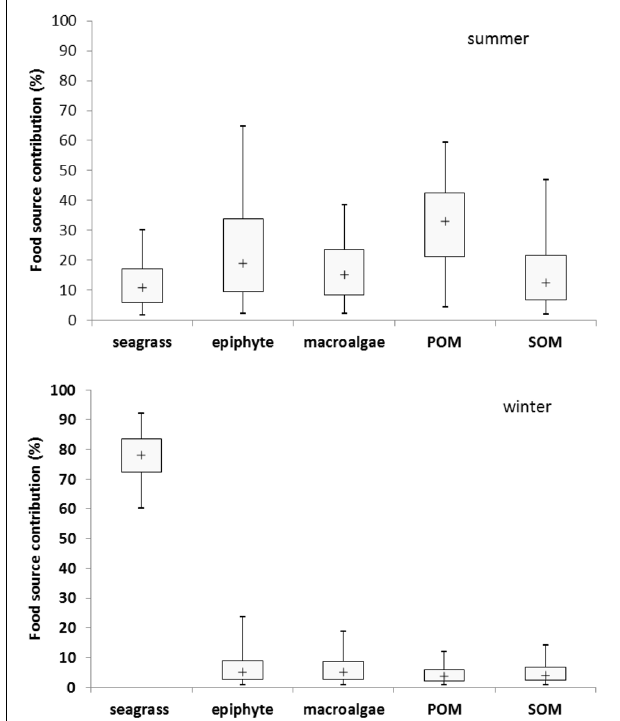
FIGURE 5 | The seasonal dietary contribution of seagrass, epiphyte, macroalgae, particulate organic matter (POM), and sediment organic matter (SOM) (%) to Monetaria annulus distributed in the seagrass bed at Li’an gang, Hainan Island.